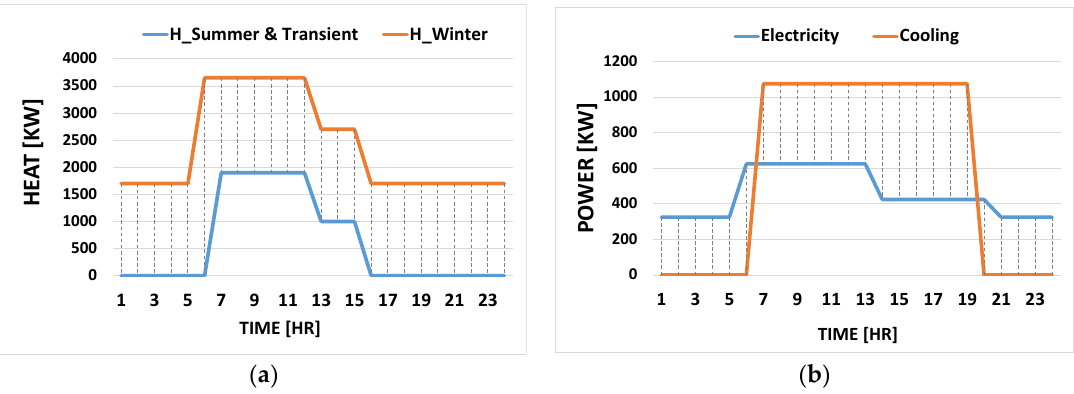
Figure 4. Heating demand ( a ) for winter, summer and transient seasons; electricity demand ( b ) for all seasons and cooling demand for typical days during the summer.